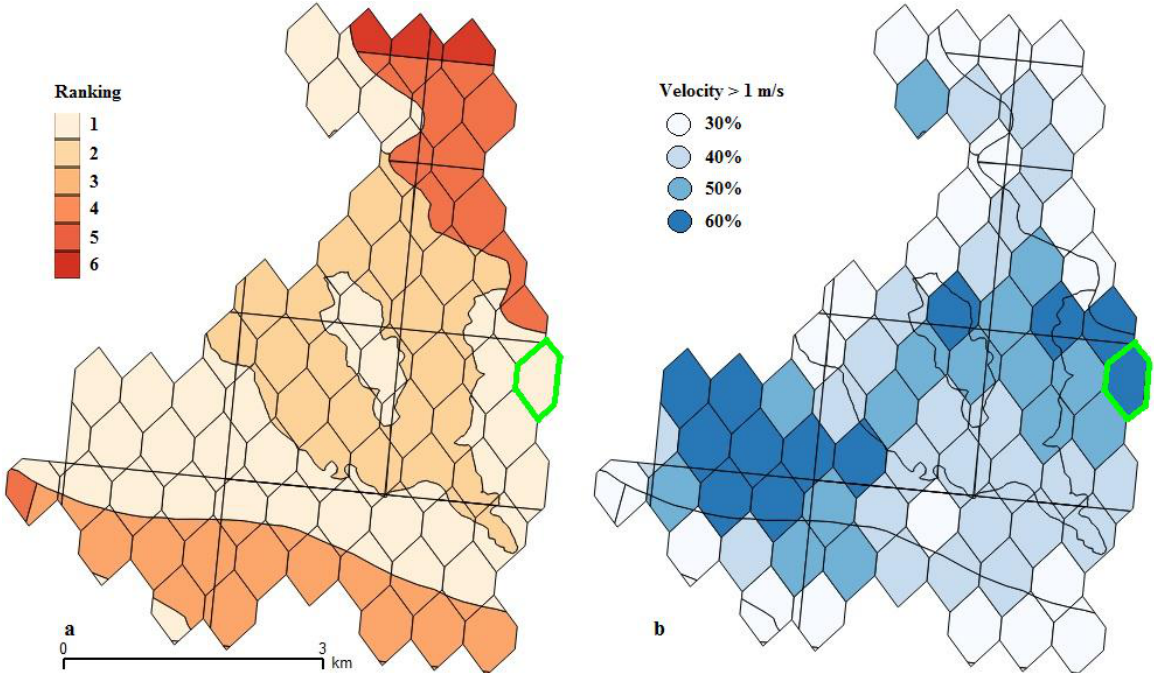
Figure 12. ( a ) Multi-criteria map social acceptance ranking visualization. ( b ) Multi-criteria map current resource